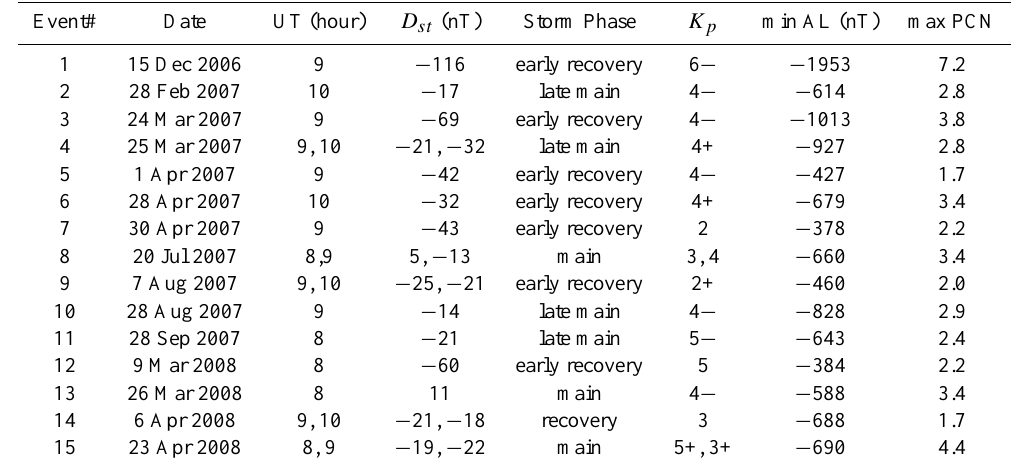
Table 1. List of westward flow enhancement as seen by Hokkaido radar.